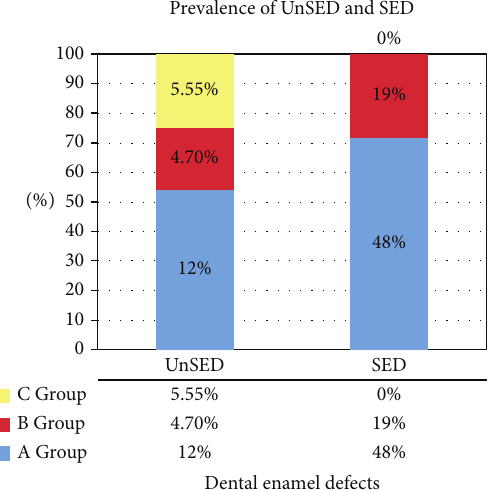
Figure 8: Prevalence of unspecific (UnSED) and specific (SED) enamel defects in all